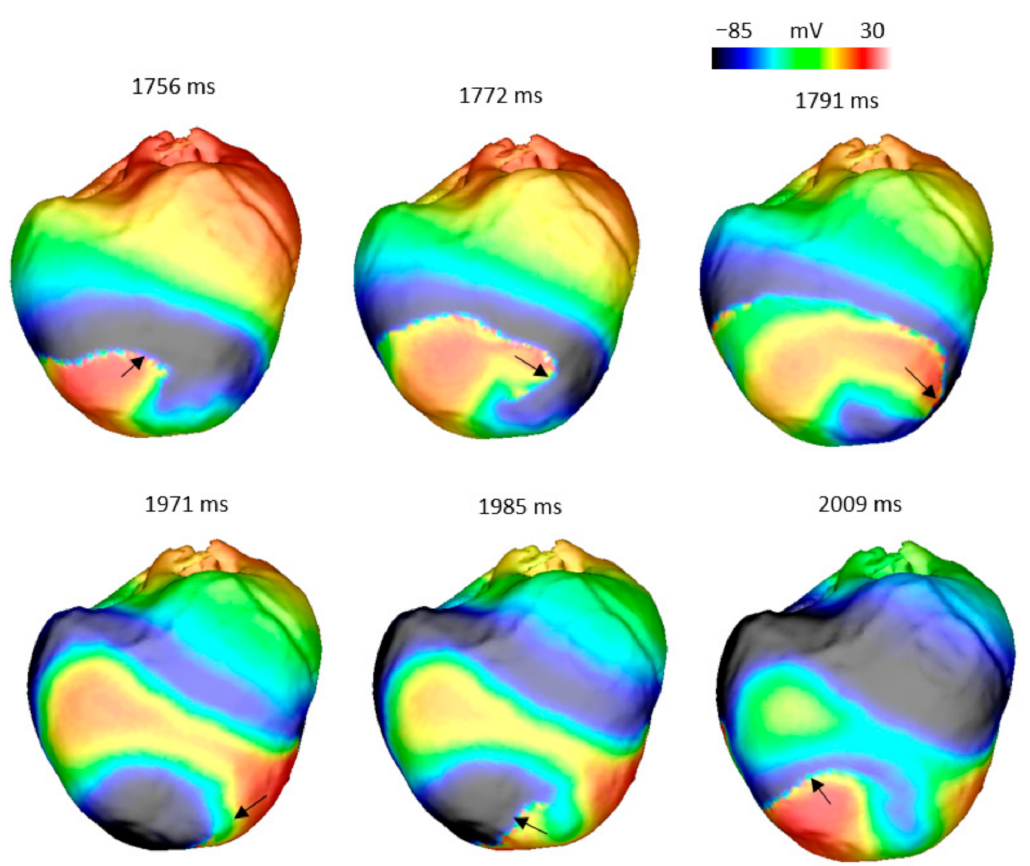
Figure 5. Macro-reentrant pattern of propagation in the ischemic ventricles around the ischemic regions ([K + ] o = 9 mM and CI = 187